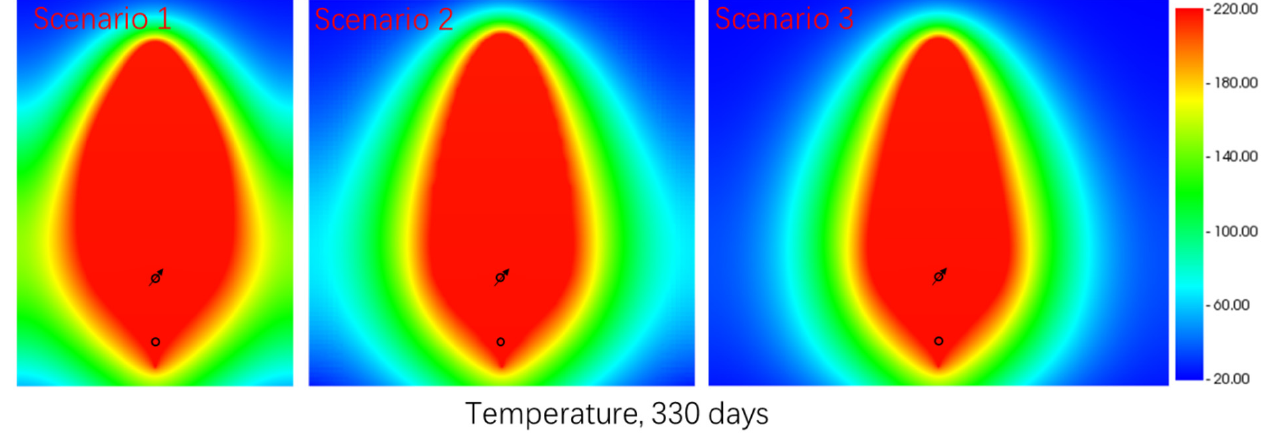
Figure 5. Cross-sectional temperature profiles of scenarios 1 to 3 under varying reservoir widths at 330 days.